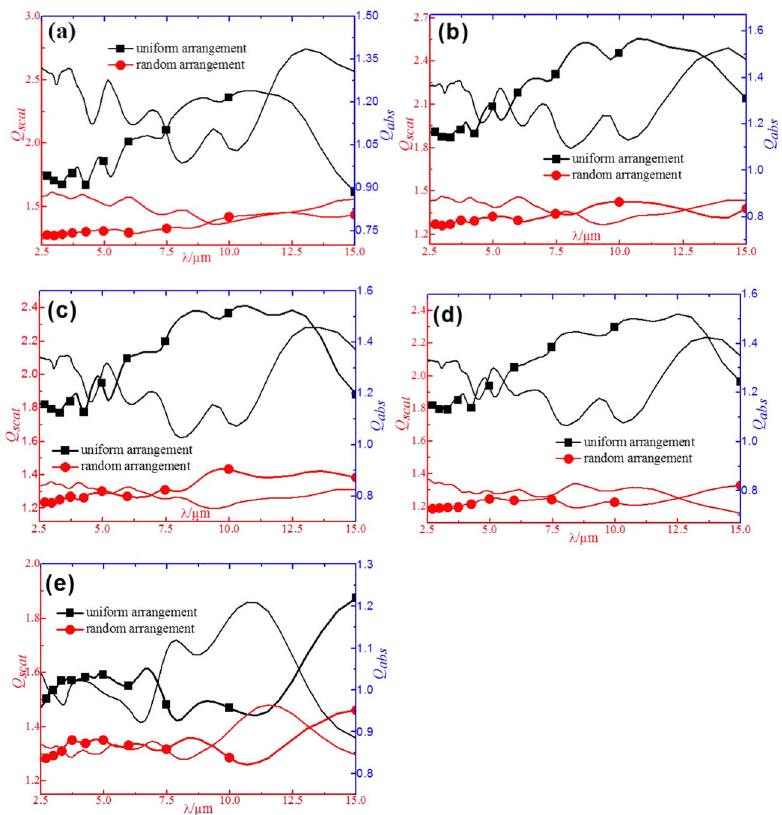
Figure 7: Scattering and absorption factor curves of carbon nano fi ber in uniform and random arrangements: ( a ) at a nano fi ber content of 39.13%, ( b ) at a nano fi ber content of 44.03%, ( c ) at a nano fi ber content of 48.92%, ( d ) at a nano fi ber content of 53.18% and ( e ) at a nano fi ber content of